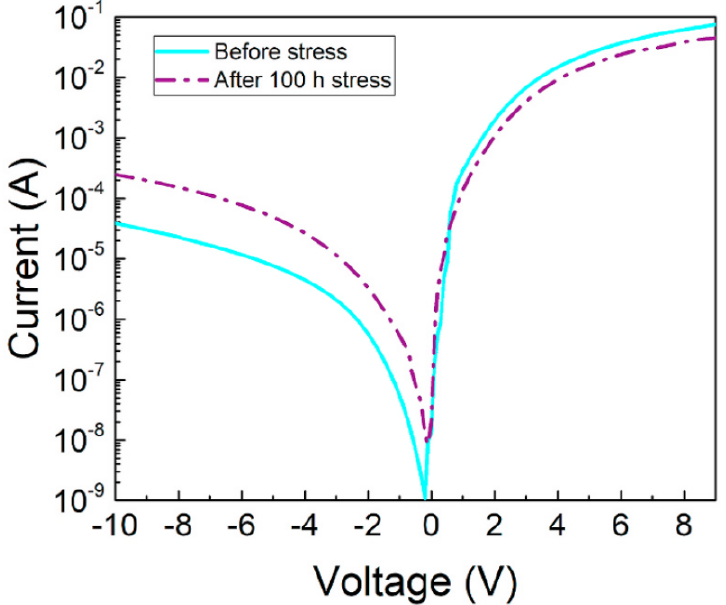
Figure 25. Typical I-V curves of (In)AlGaN-based DUV LED measured before and after stress treatment. Reproduced with permission. [75] Copyright 2020, Elsevier.